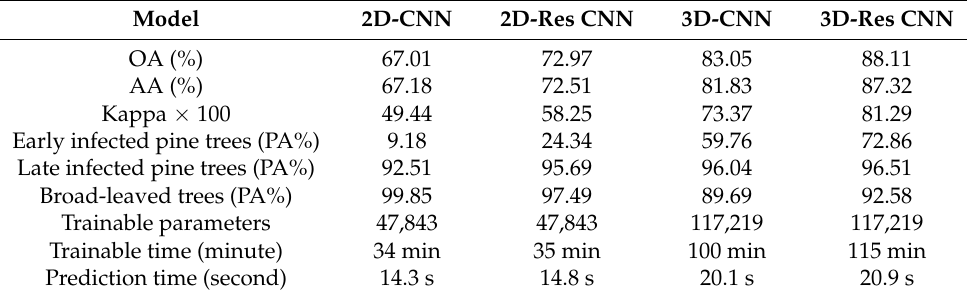
Table 4. Classification accuracy of three classes using different approaches.